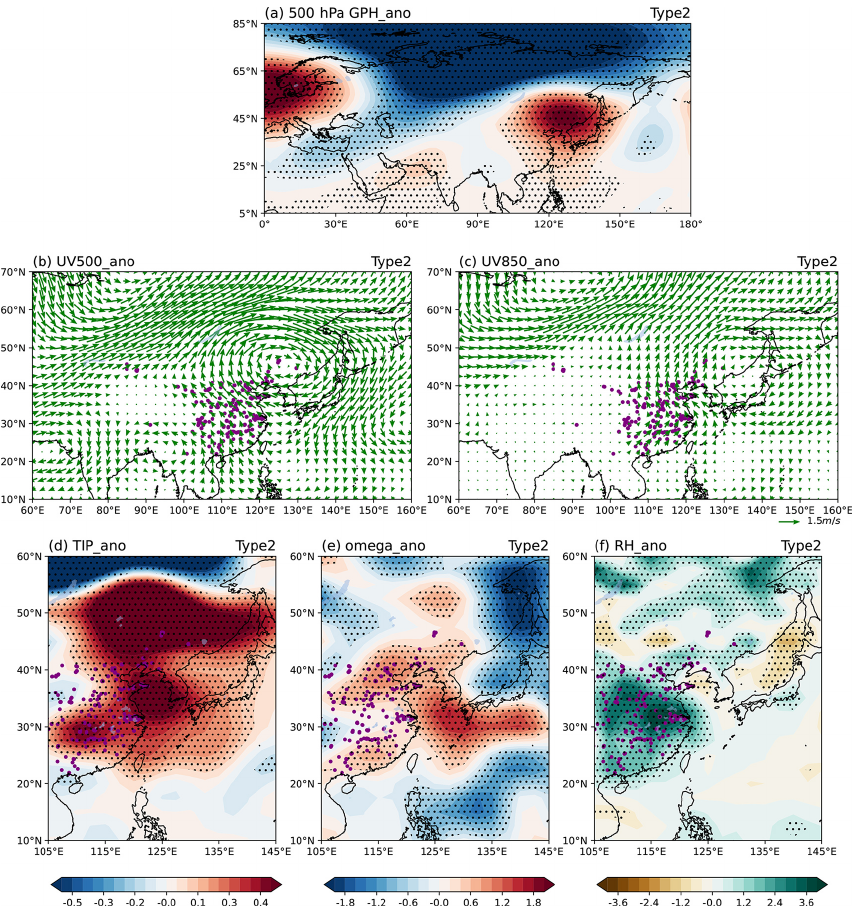
Figure 6. Composite anomalies of (a) GPH at 500hPa (unit: gpm), horizontal wind (unit: ms − 1 ) at (b) 500hPa and (c) 850hPa, (d) TIP (unit: K), (e) omega (unit: 10 − 2 Pas − 1 ), and (f) RH (unit: %) for circulation Type2. Dotted areas are statistically significant at the 95% confidence level.